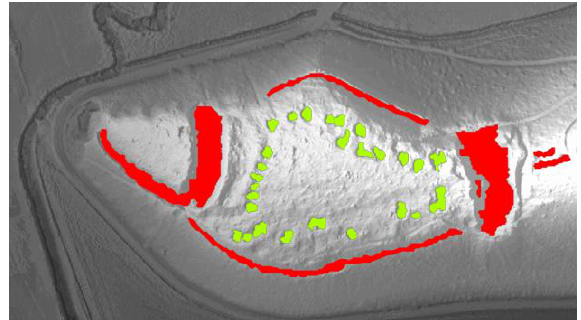
Figure 9. Radkov – vectorised terrain relics